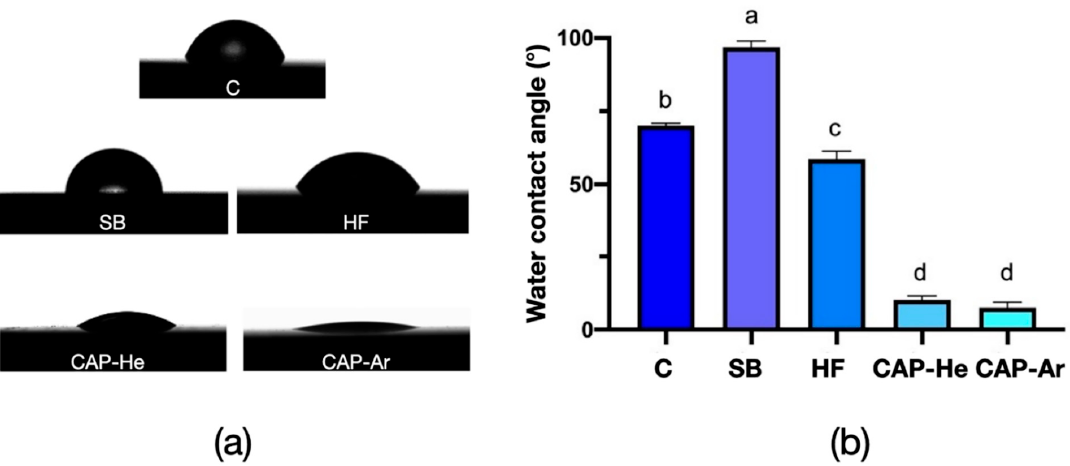
Figure 4. Water contact angle of RNC specimens. ( a ) classical images of each group; ( b ) statistical analysis of water contact angle values, and different letters denote significant differences ( p < 0.05).